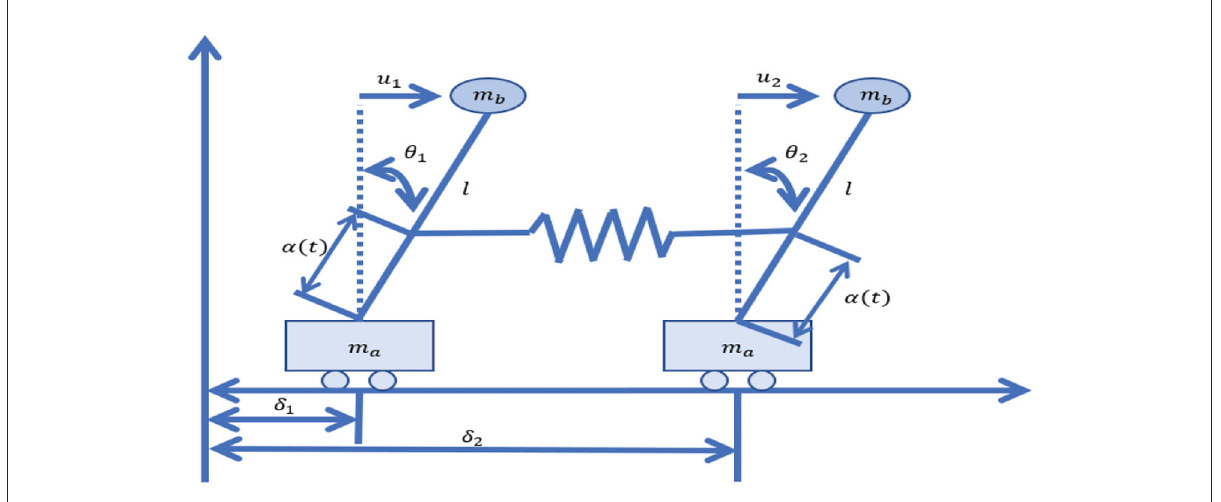
Figure 2B, indicating that the parameter updating law (Equation